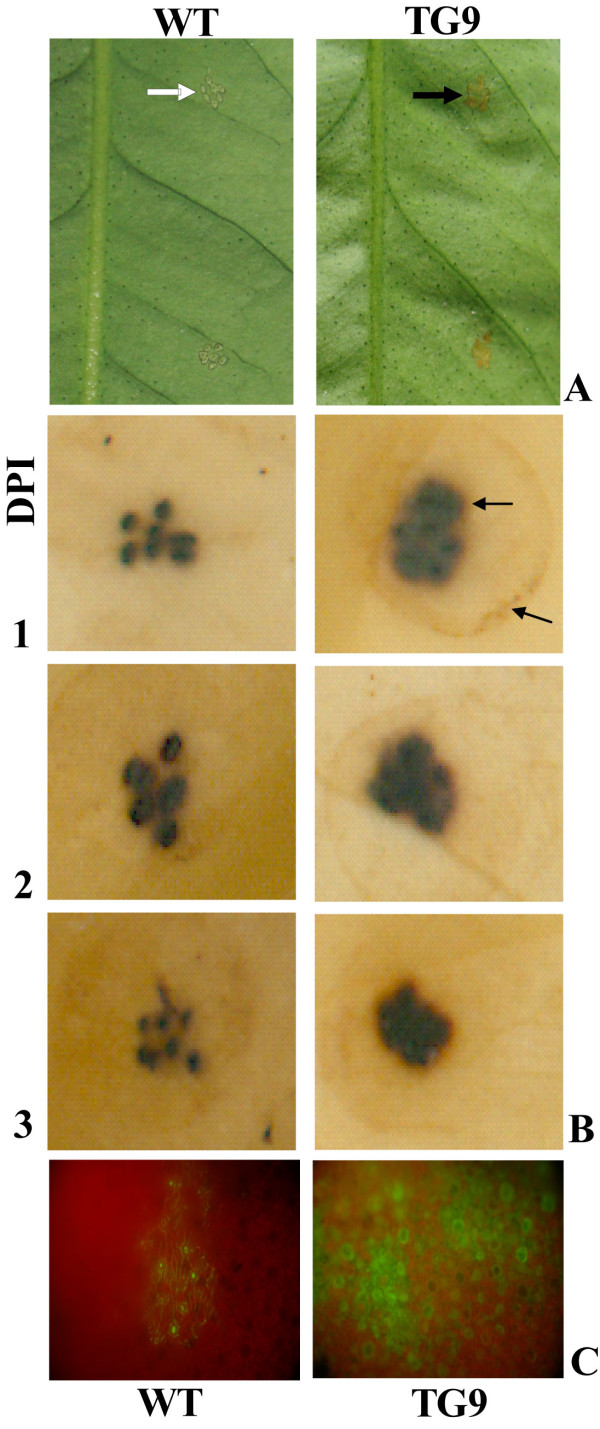
Hypersensitive reaction and assay of H2O2 at the inoculation sites and in the neighboring regions of the wild type (WT) and transgenic line (TG9) leaves after Xac inoculation. (A) Representative photos showing the WT and TG9 leaves after 3 d of Xac inoculation. Arrows show the occurrence of HR at the inoculation sites. (B-C) In situ accumulation of H2O2 in the WT and TG9 leaves, as revealed by histochemical staining assay via 3, 3'-diaminobenzidine (B) and H2DCF-DA (C), respectively.